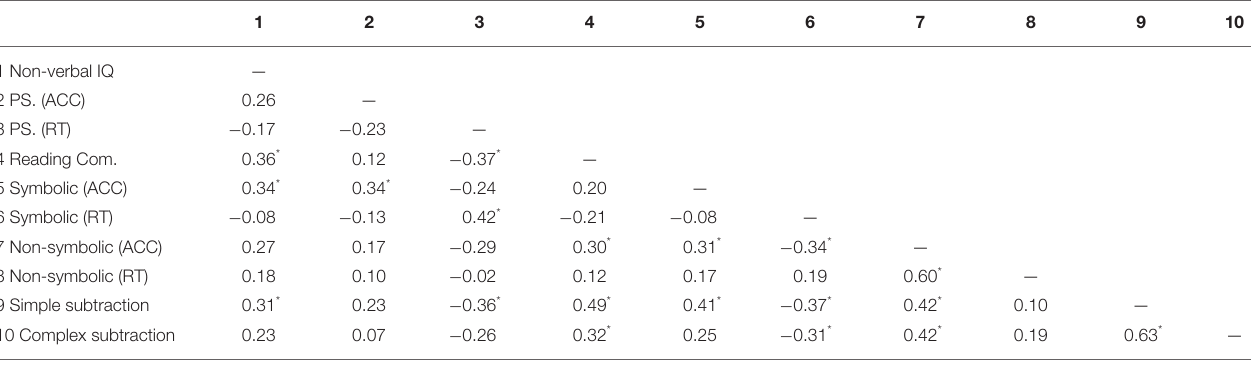
TABLE 5 | Partial correlations after controlling for age and gender differences among all the test scores.